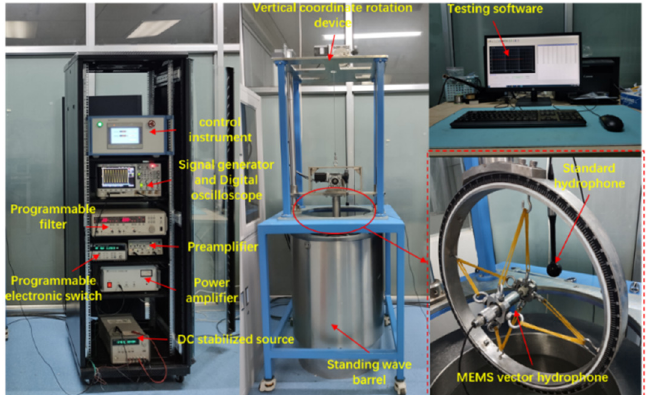
Figure 9. Calibration site in standing wave tube.